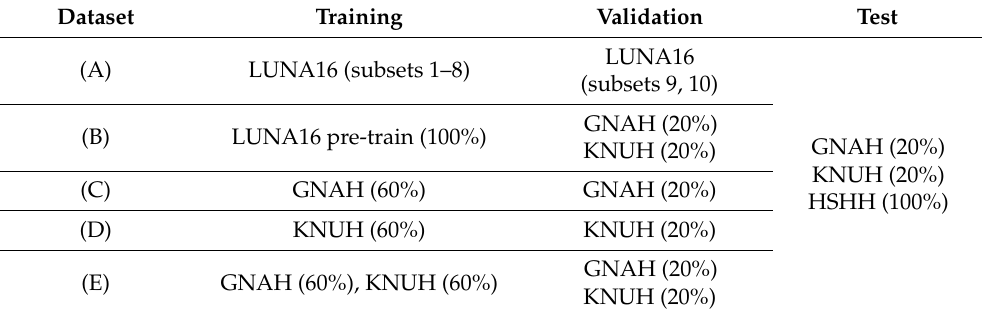
Table 2. Dataset configurations used in the